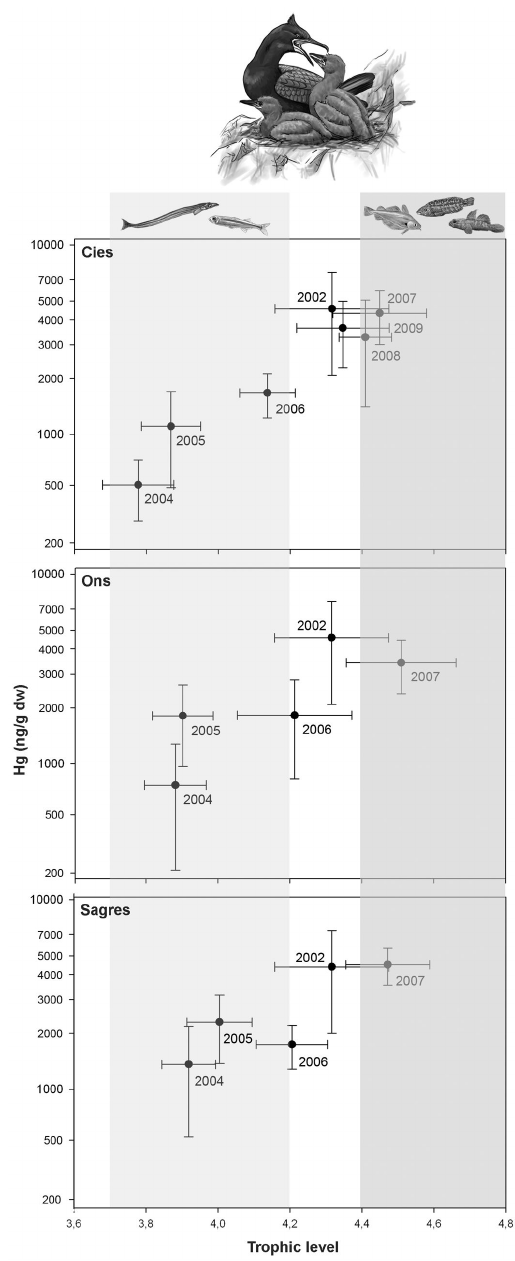
Figure 3. Plot of Hg concentrations (ng/g dry weight in logarithmic scale) and trophic position (mean ± S.D.) in feathers of European shag chicks sampled at three affected colonies from 2004 to 2009 and in feathers from juvenile carcasses collected during the Prestige accident representing pre-spill values from 2002, reflecting the diet change due to the wreck. Light grey box : chicks with values corresponding to a diet on a higher percentage of pelagic/ semipelagic species. Dark grey box : chicks with values corresponding to a diet on a higher percentage of demersal and benthic fish. Draws are courtesy from Martin Franch Rodriguez. doi: